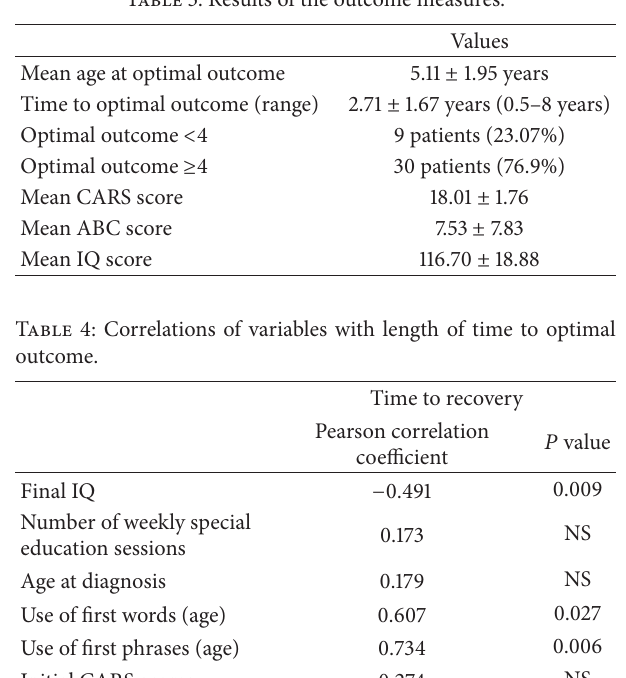
Table 3: Results of the outcome measures.